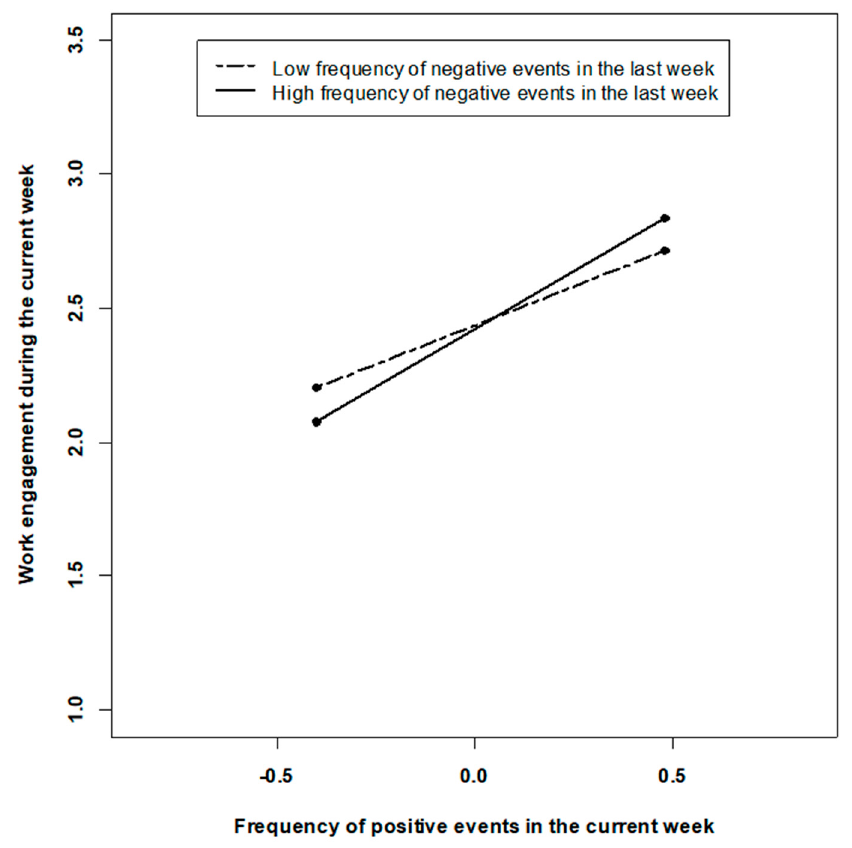
Figure 2. Interaction of current positive and lagged negative events at the week-level.